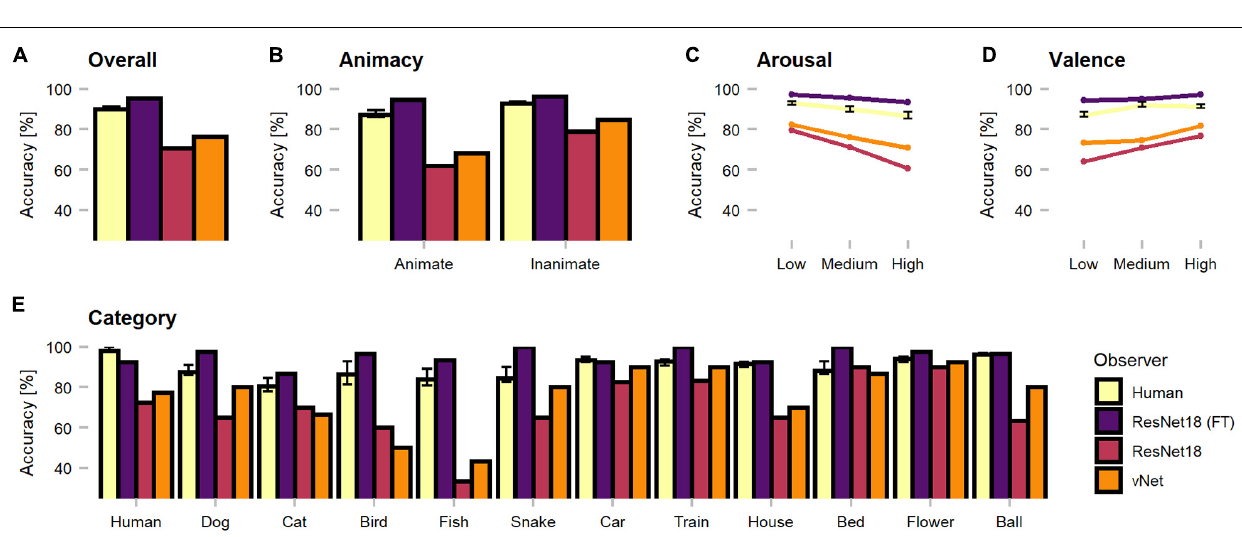
FIGURE 4 | Object recognition accuracy of the human observer sample, fine-tuned ResNet18 (marked as FT), and both trained-from-scratch ResNet18 and vNet. Remarkably, vNet is more accurate then ResNet18 across all grouping variables. (A) Human observers were outperformed by fine-tuned ResNet18 but more accurate than both ResNet18 and vNet. (B) Human observers were better at recognizing inanimate compared to animate objects. This relationship held for DCNNs as well. (C) The effect of arousal on human observers indicated more inaccurate recognition with increasing arousal. (D) The effect of valence on human observers indicated more accurate recognition with increasing valence. (E) Human observers showed a small effect of category, while both trained from scratch DCNNs faced large variability between individual categories. Confidence intervals for the human observer sample were estimated with Hodges-Lehmann procedure on a significance level of p =